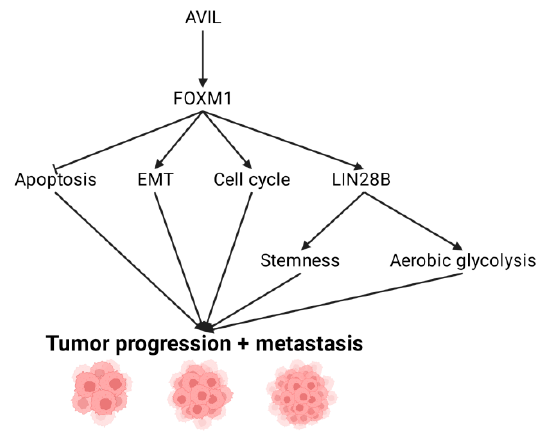
Figure 4. Overview of AVIL oncogenic functions through the FOXM1-LIN28